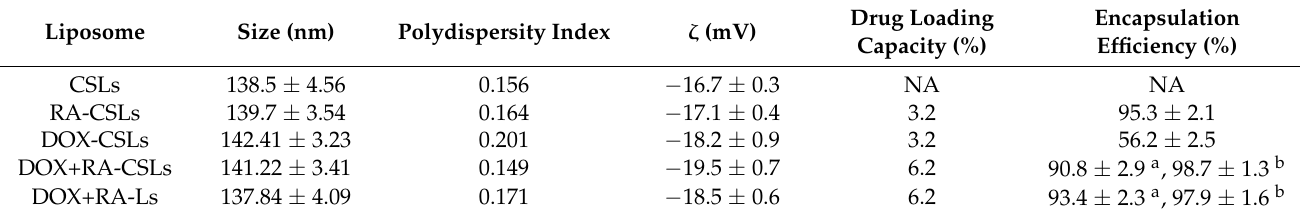
Figure 1. Physical properties of liposomes encapsulating both doxorubicin (DOX) and retinoic acid (RA) (DOX+RA-CSLs). ( A ) hypothesized structure of a single DOX+RA-CSL; ( B ) representative transmission electron micrograph of DOX+RA-CSLs; ( C ) diameter of DOX+RA-CSLs determined by dynamic light scattering; ( D ) stability of DOX+RA-CSL particles in the presence of 10% fetal bovine serum. Data are expressed as mean ± SD ( n = 3). Table 1. Physical properties of various liposome